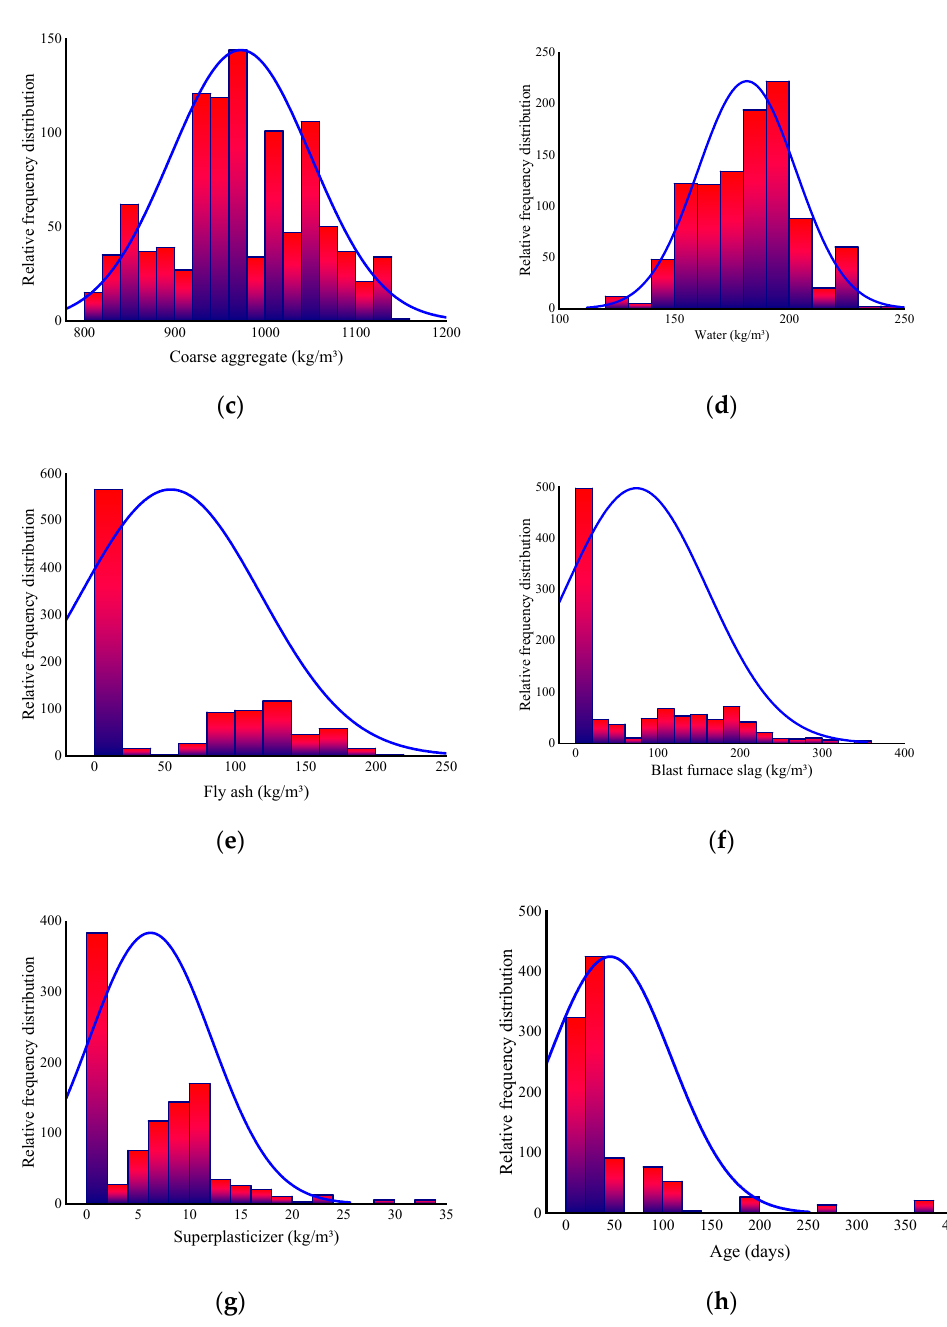
Figure 1. Relative frequency distribution of input parameters: ( a ) Cement; ( b ) Fine aggregate; ( c ) Coarse aggregate; ( d ) Water; ( e ) Fly ash; ( f ) Blast furnace slag; ( g ) Superplasticizer; ( h ) Age.